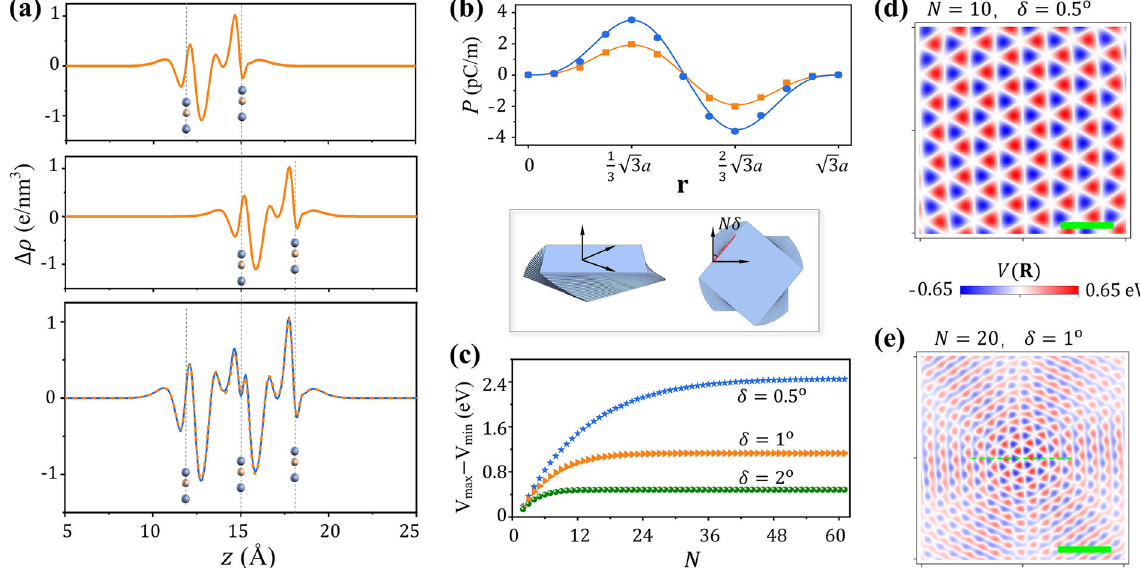
Fig. 4 Scaling up the superlattice potential using AB h-BN fi lm subject to torsion. a Top panel: charge variation Δ ρ due to interlayer coupling in AB bilayer. Middle: same as top, with shifted atomic planes. Bottom: charge redistribution due to interlayer coupling in AB trilayers. Blue curve plots Δ ρ (cid:3) ρ 3L (cid:1) ρ t (cid:1) ρ m (cid:1) ρ b , where ρ 3L is trilayer charge density from DFT, and ρ t/m/b is that of the pristine top/middle/bottom monolayer. Orange curve is the sum of two curves in top and bottom panels. b Blue dots show electrical polarization in lattice-matched trilayers with two parallel interfaces of the identical registry r , and orange squares show that in bilayer h-BN. c Strength of superlattice potential in N -layer fi lm under torsion where adjacent layers are all twisted with a common angle δ (c.f. inset). d , e Spatial pro fi les of superlattice potentials on the surface of 10-layer fi lm with δ = 0.5°, and 20-layer fi lm with δ = 1°. A chiral structure is seen in the latter. Green scale bar is 50